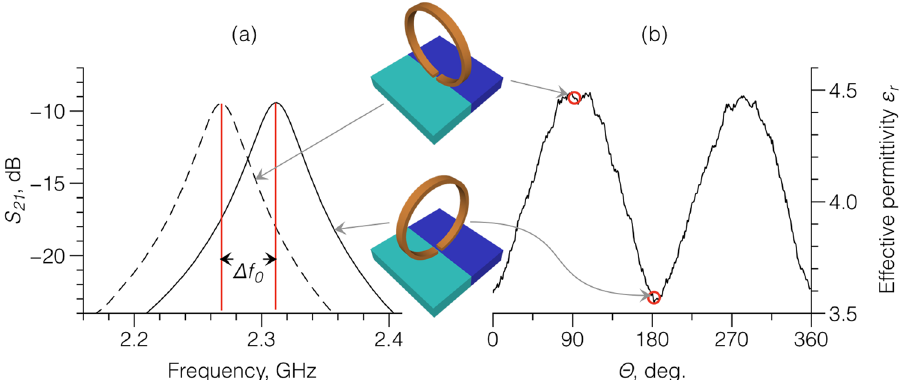
Figure 3. ( a ) Simulation of the transmission coefficient S 21 for a SRR dielectric probe oriented parallel (left- shifted curve) and perpendicular (right-shifted curve) to the boundary between two materials with different permittivities ε 1 = 2.6 and ε 2 = 7.2; and ( b ) the measured effective relative dielectric permittivity at the interface region of the two materials ε 1 and ε 2 as a function of the rotation